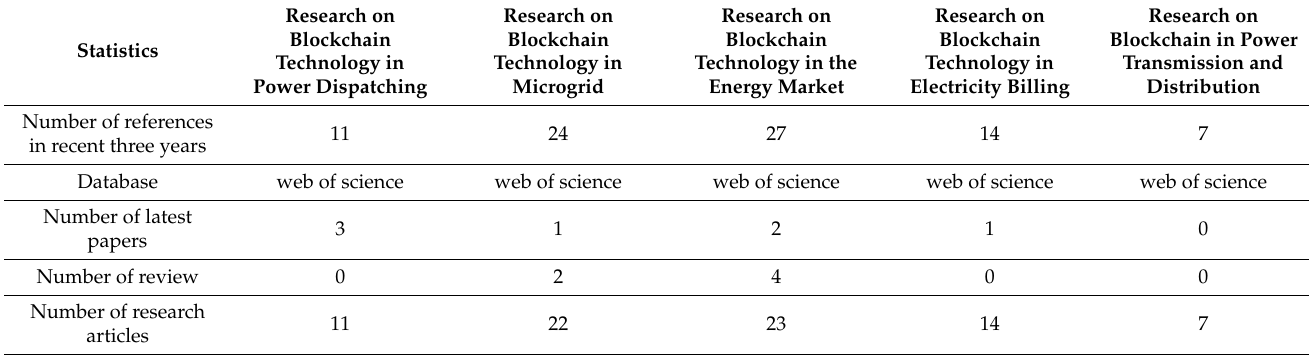
Table 1. Statistical table of various application scenarios in the